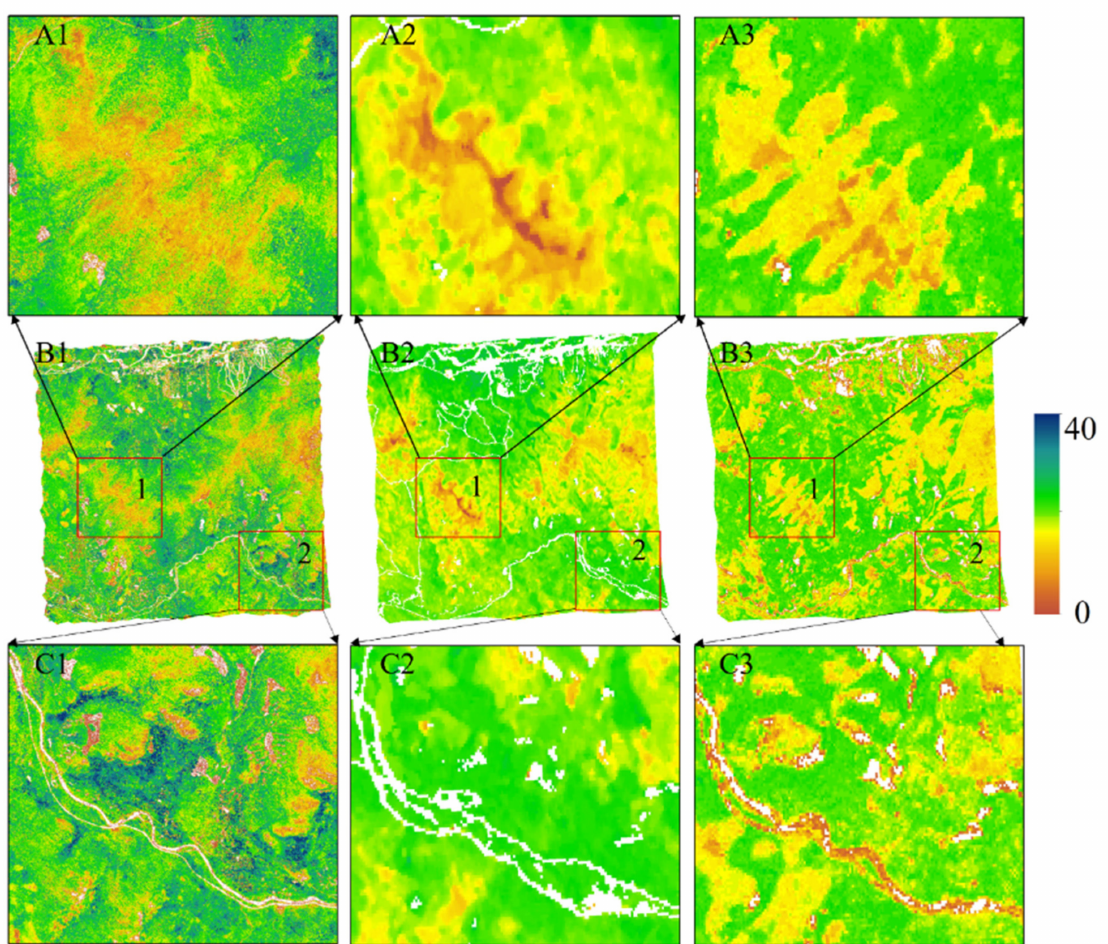
Figure 6. Comparison of canopy height spatial distributions among NEON CHM, C-CH, and GDAL RH95. The ( A1 – A3 , C1 – C3 ) are the sub-regions of ‘1’, and ‘2’ rectangles in ( B1 – B3 ). The ( B1 – B3 ) represent the NEON CHM, C-CH, and GDAL RH95, respectively. To be comparative, the canopy heights have the same scale, ranging from 0 to 40 m. Masked areas are displayed in